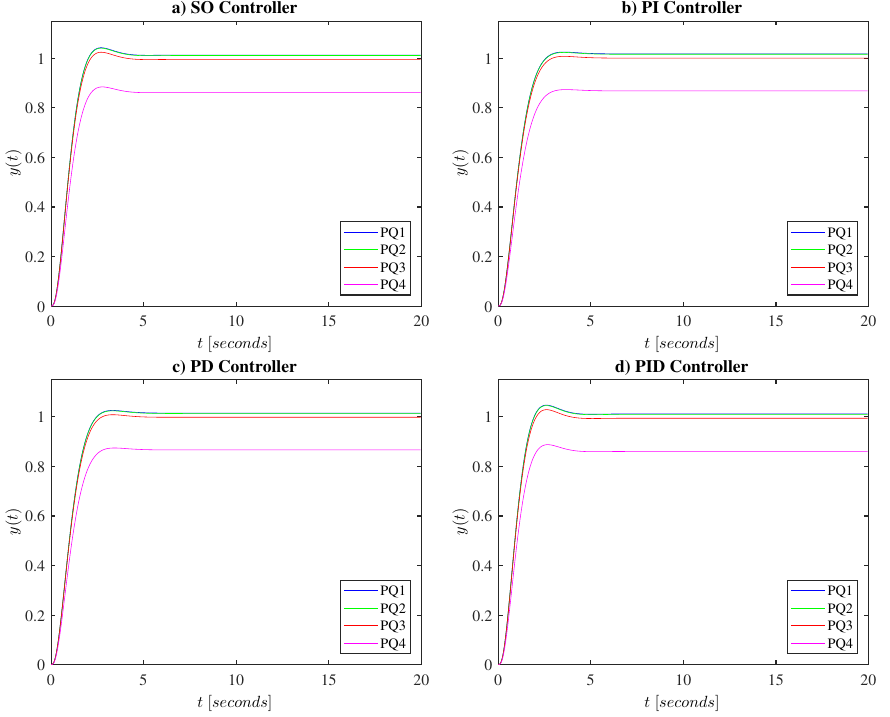
Figure 7. Optimization process results for the output y ( t ) .